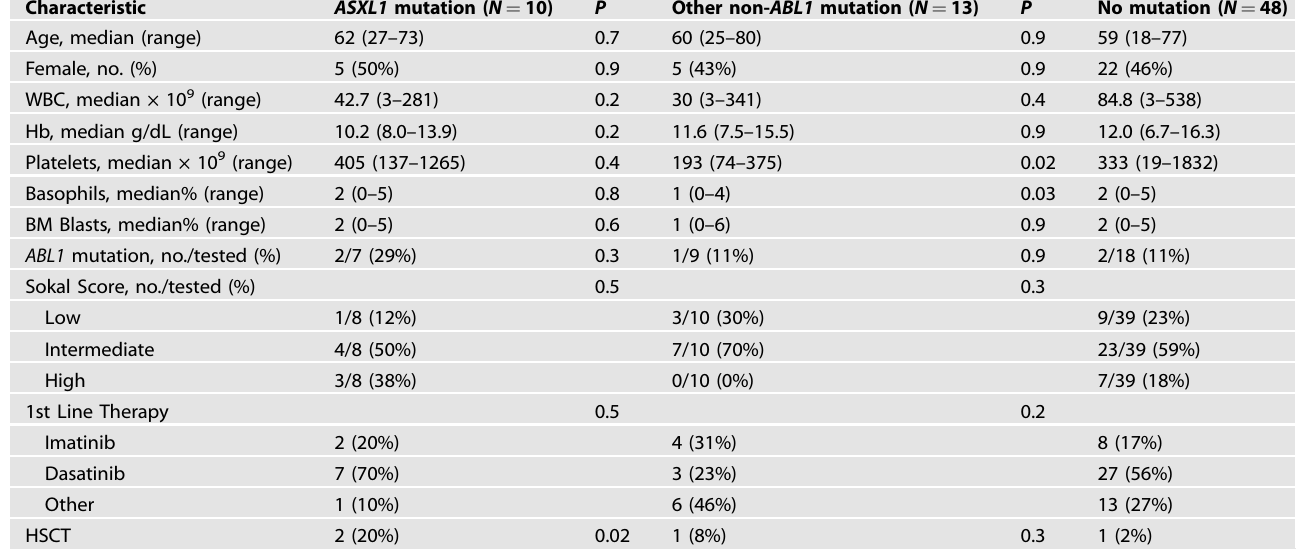
Table 1. Baseline